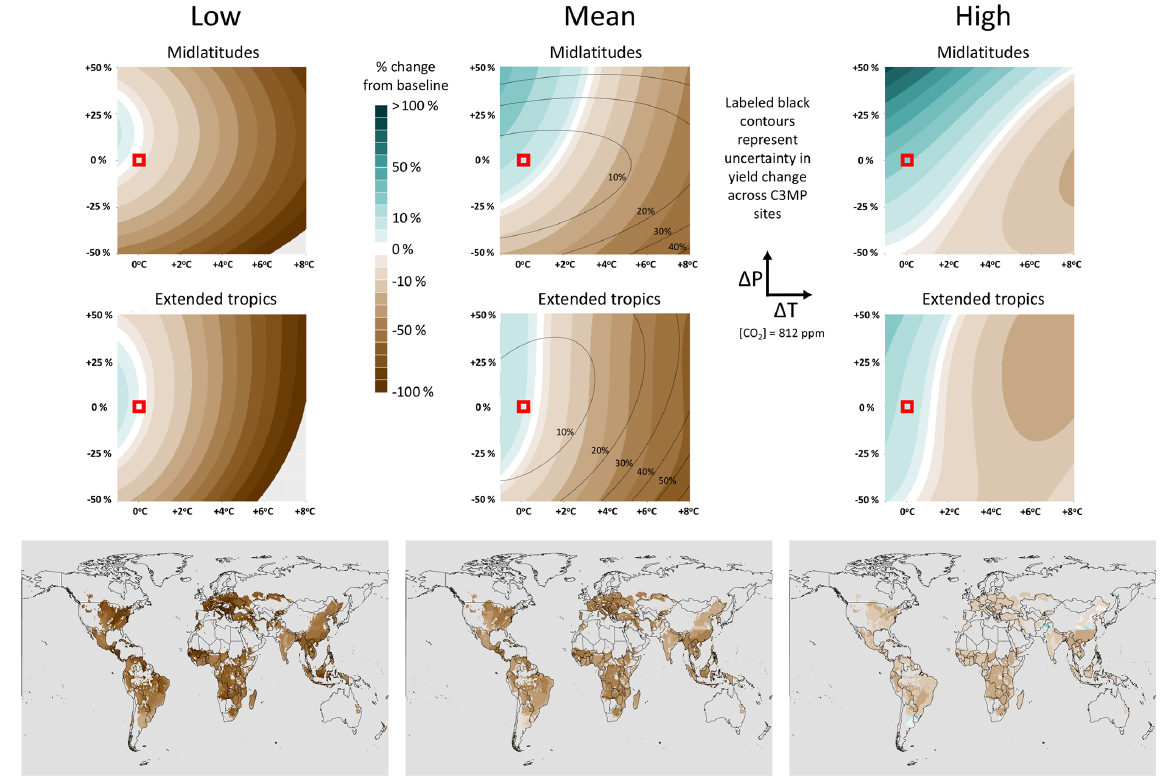
Figure 11. Low, mean, and high response surfaces for the midlatitudes (top row) and extended tropics (middle row) for rain-fed maize, as well as the resulting maps of yield changes under the same HadGEM2-ES RCP8.5 2071–2100 CTW changes as Fig.